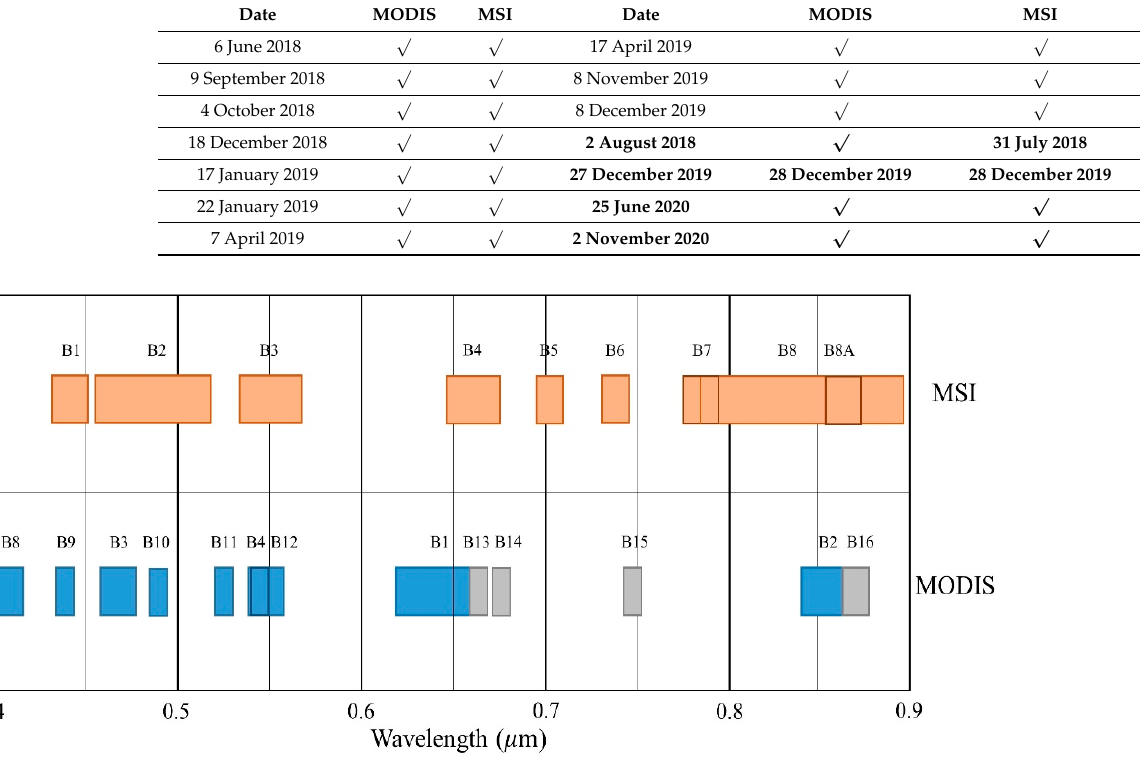
Figure 2. Distribution of MODIS and MSI bands (B) with wavelengths between 0.4 and 0.9 μ m. MOO09 B13–B16 (suffering saturation with gray) were not included in this